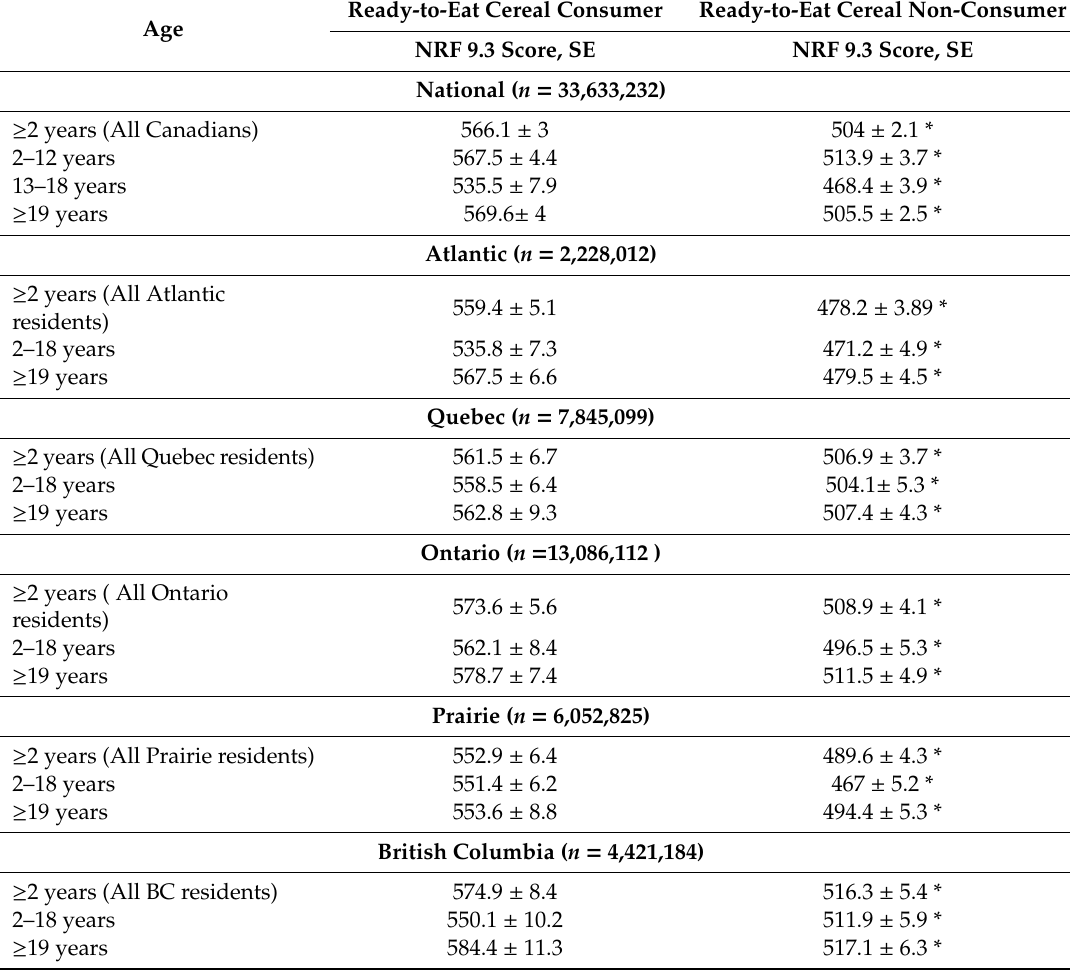
Table 5. Represents NRF 9.3 score of RTEC consumers and non-consumers across Canada and the regions 1